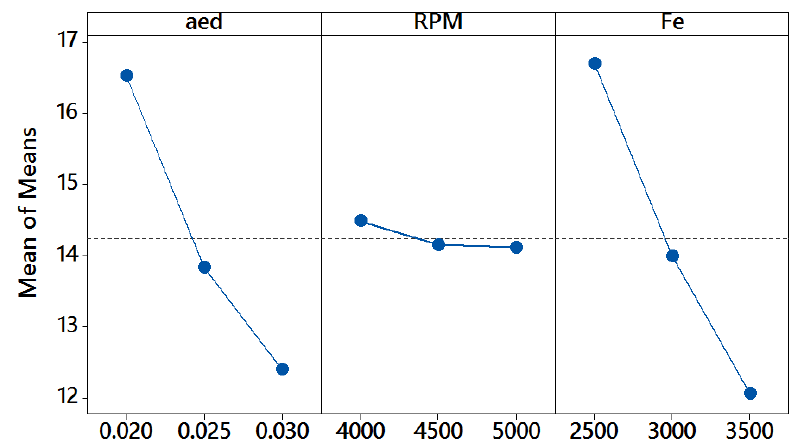
Table 7. The ANOVA values for S/N ratios. Figure 2. Main effect plots of cutting parameters for means of grinding time ( t̅ ).